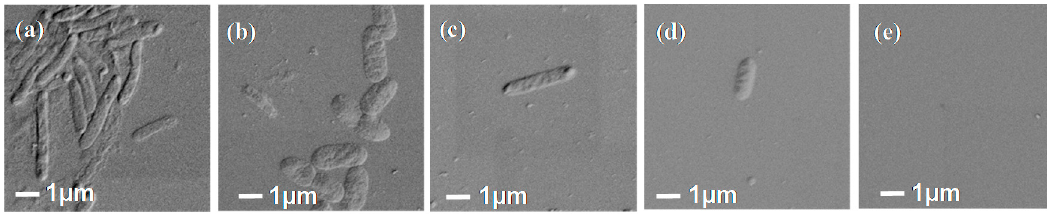
Figure 7. Epifluorescence images of human mesenchymal stem cell, MG63 osteoblast-like cell and P. aeruginosa attachment to PEG grafted under different conditions: ( a – c ) Si wafer control, ( d – f ) 4% APTES, ( g – i ) 4% APTES_PEG 0 M K 2 SO 4 , ( j – l ) 4% APTES_PEG 0.3 M K 2 SO 4 , and ( m – o ) 4% APTES_PEG 0.6 M K 2 SO 4 .